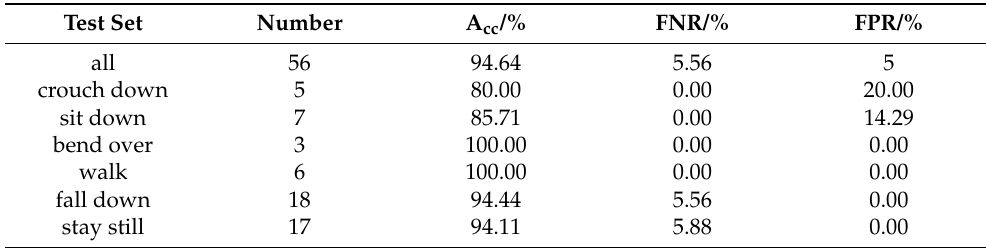
Table 4. Results of behavior